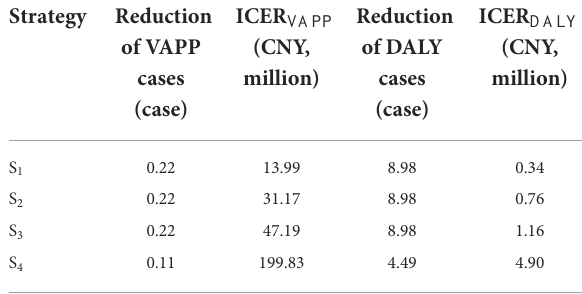
TABLE 4 ICER of S 1 /S 2 /S 3 /S 4